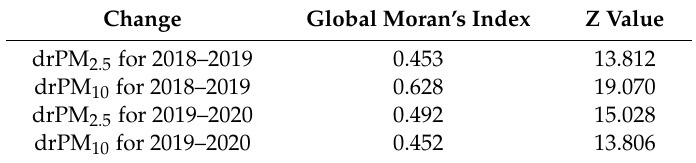
Table 3. Global Moran’s indexes for the decline rates in 2018–2019 and 2019–2020 of PM pollutants. Change Global Moran’s Index